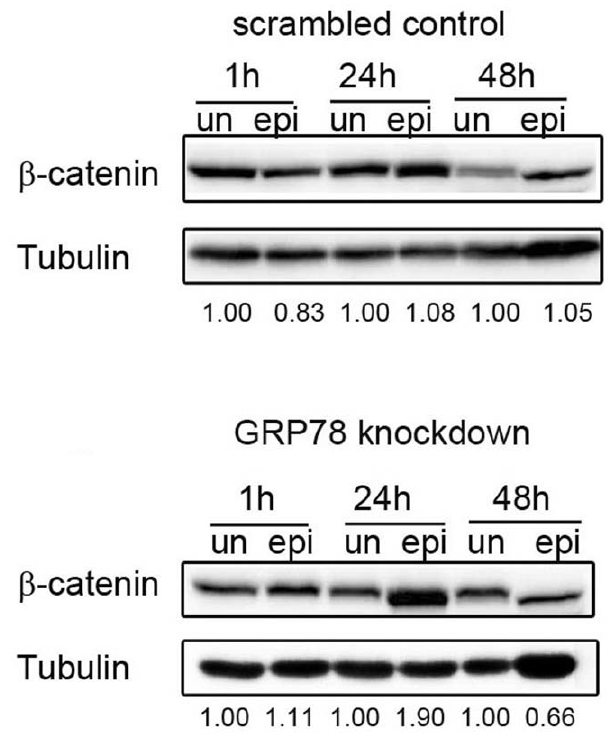
Figure 5. Expression of b -catenin after epirubicin (epi) treat- ment. Scrambled control and GRP78 knockdown DLD-1 cells were treated with epirubicin (500 ng/ml) for the indicated times, and the expression of b -catenin was evaluated by western blotting. These experiments were performed at least 3 times, and a representative experiment is